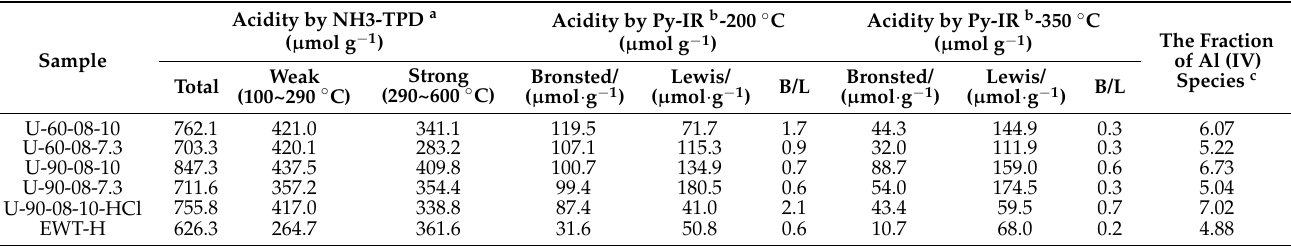
Figure 9. The NH 3 -TPD profiles of samples.